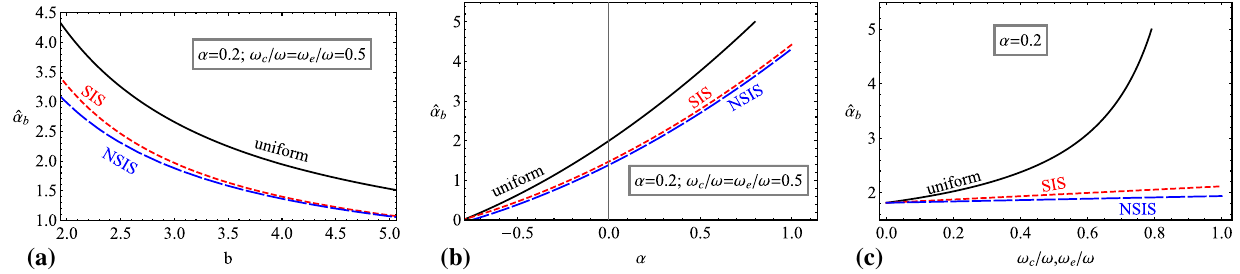
b = r c = 3 M , ω c /ω = 0 . 5 and the right one b = r c = 3 M , α = 0 . 2. In these plots we have compared the effects of uniform, the SIS and NSIS models for the fixed value of plasma density